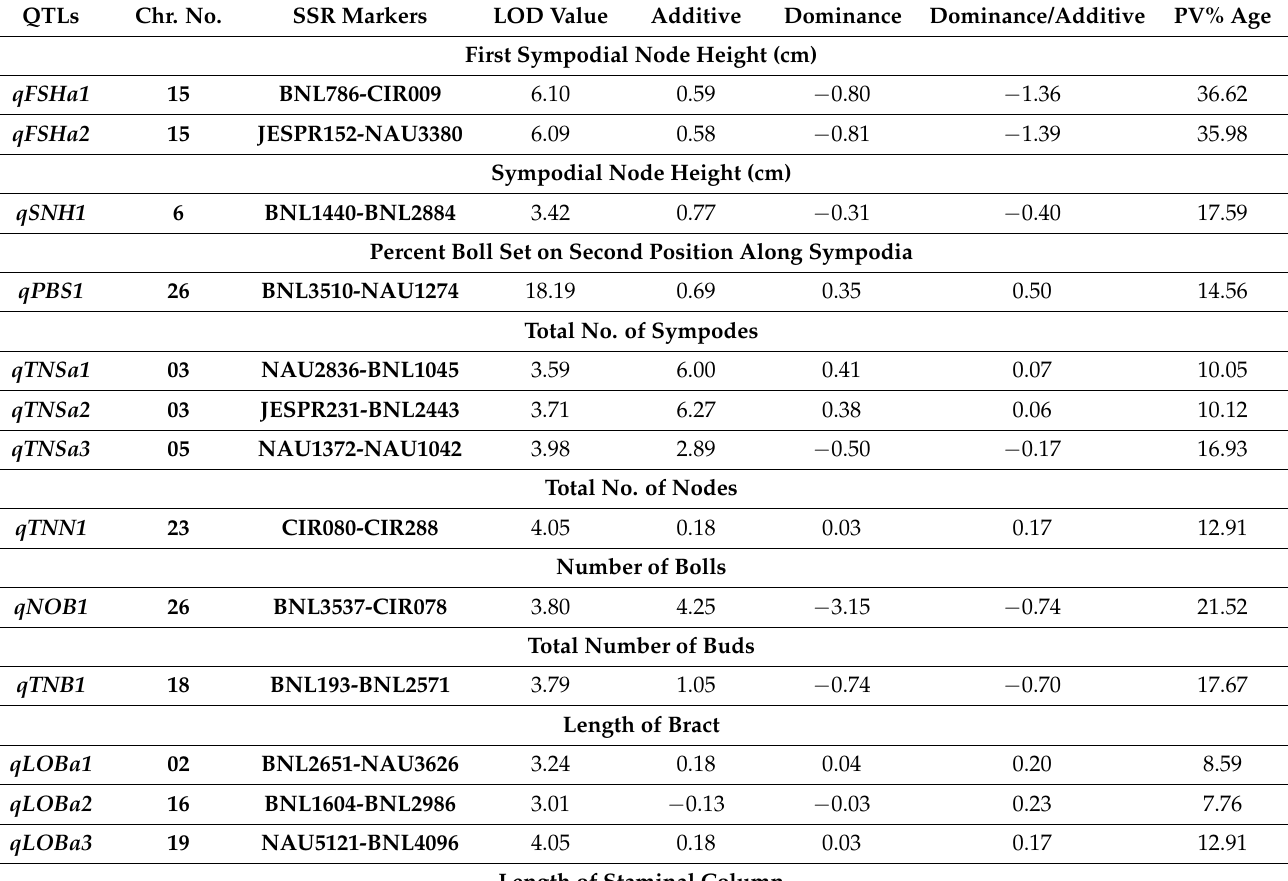
Table 6. QTLs related to heat tolerance in Intraspecific cross among MNH-886 and MNH-814. (LOD = Logarithm of odds, Additive = Additional effects, Dominance/additive = ratio between dominance and additive effects, PV% = Phenotypic